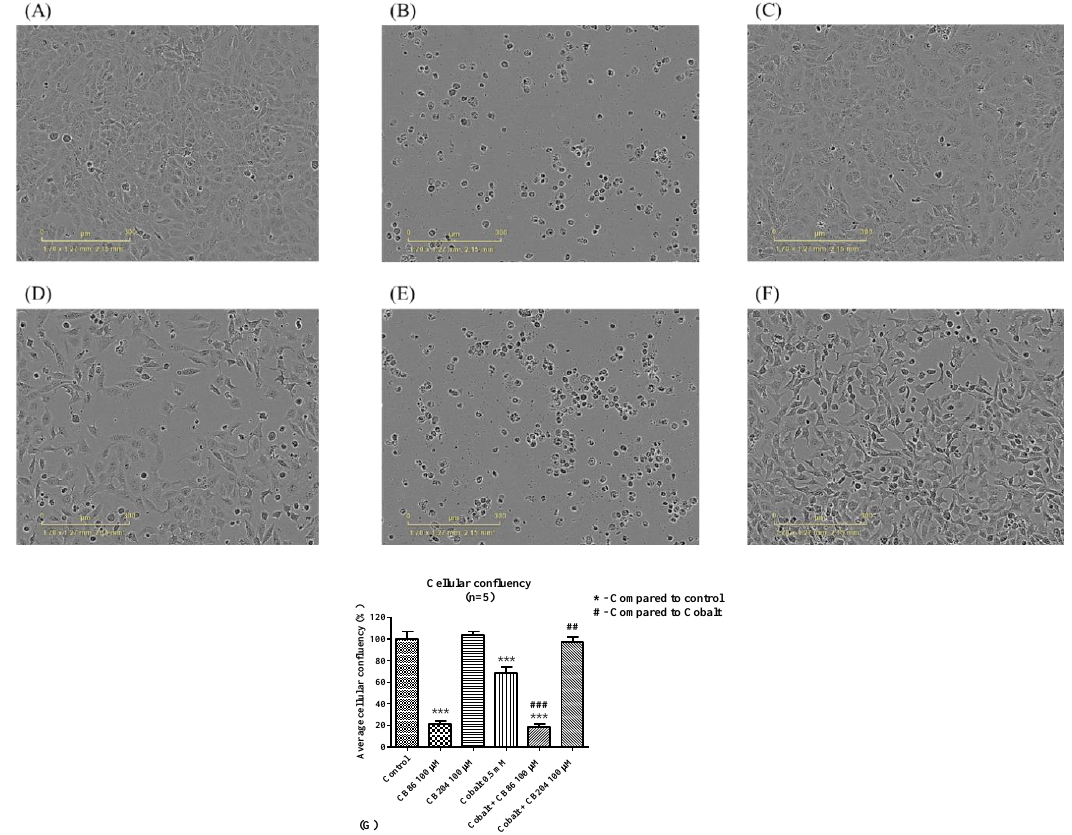
Figure 8. The effects of CB86 and CB204 on reductions of cell density caused by CoCl 2 . Photographs showing the density of H1299 cells in ( A ) control group, ( B ) following pretreatment with the high affinity CB86 ligand alone (100 µM), ( C ) following pretreatment with the low affinity CB204 ligand alone (100 µM), ( D ) following exposure to 0.5 mM of CoCl 2 , ( E ) following pretreatment with the high affinity CB86 at a concentration of 100 µM and exposure to 0.5 mM CoCl 2 , ( F ) following pretreatment with the low affinity CB204 at a concentration of 100 µM and exposure to 0.5 mM CoCl 2 , and ( G ) a bar graph summarizing the results. Results in figure 8G are presented as mean ± SEM ( n = 5 replicates in each group). ## p < 0.01, ### and *** p < 0.001.